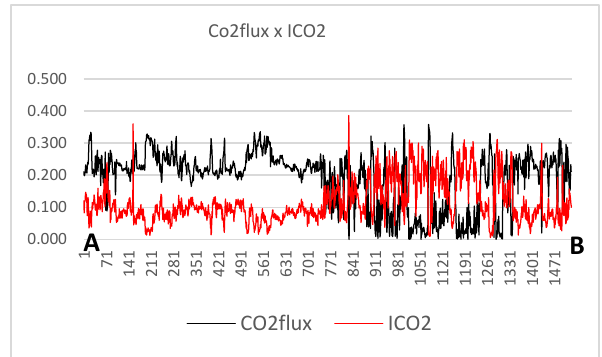
Graph 1. Comparison chart of the variations between the ICO 2 and CO 2 flux indexes applied along transect